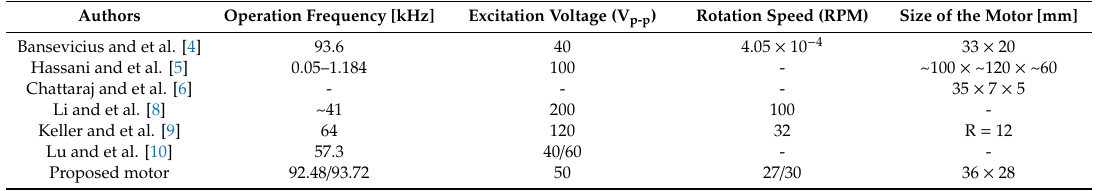
Table 1. Comparison of the parameters of reviewed and proposed motors.